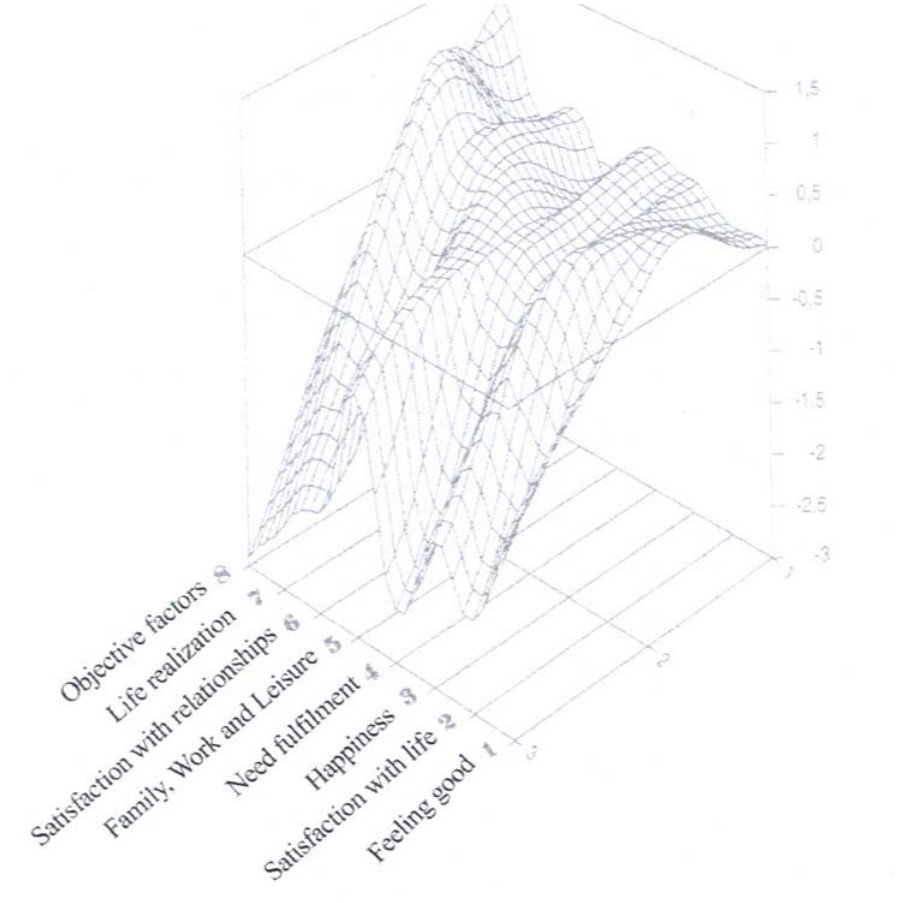
FIGURE 2. Quality of life (z-axis), as measured according to eight quality-of-life theories (y-axis), against maternal smoking in the third trimester (x-axis). Data from Table 4,